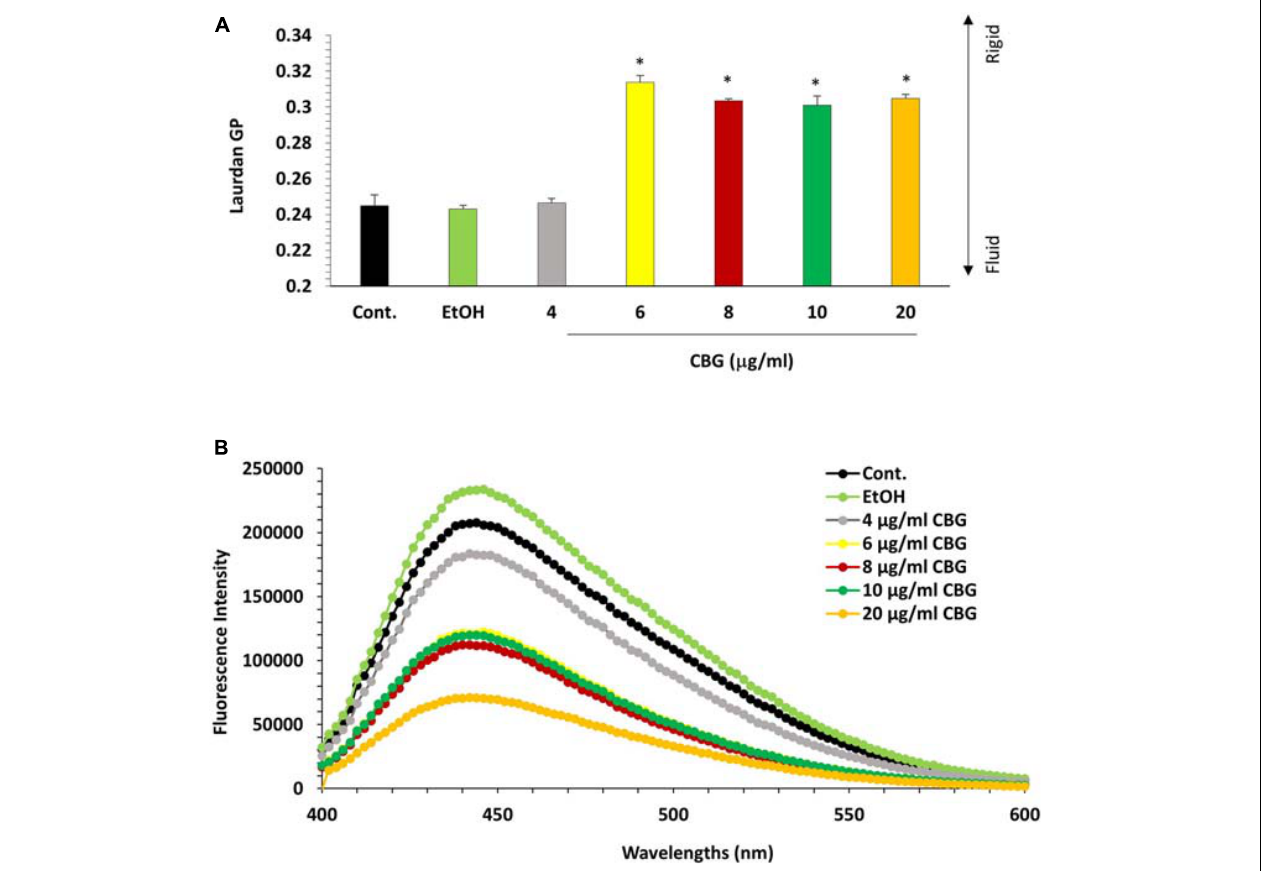
FIGURE 8 | CBG reduces S. mutans membrane fluidity. (A) Laurdan generalized polarization (GP) values in S. mutans treated with various concentrations of CBG (0–20 µ g/ml) for 2 h. n = 3; * p < 0.05. (B) Fluorescence intensity scan of laurdan stained S. mutans that have been treated with different CBG concentrations (0–20 µ g/ml) or EtOH for 2 h.